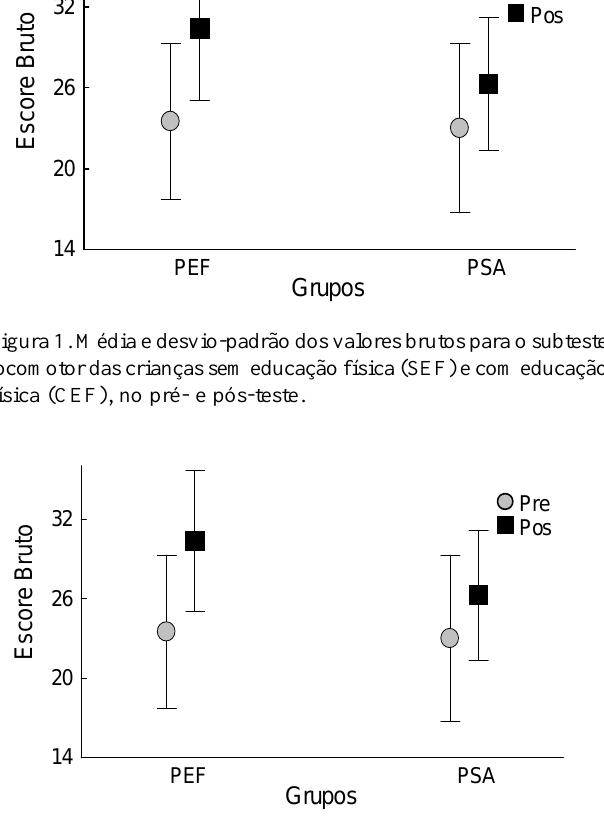
Figura 2. Média e desvio-padrão dos valores brutos do subteste controle de objeto das crianças sem educação física (SEF) e com educação física (CEF), no pré- e